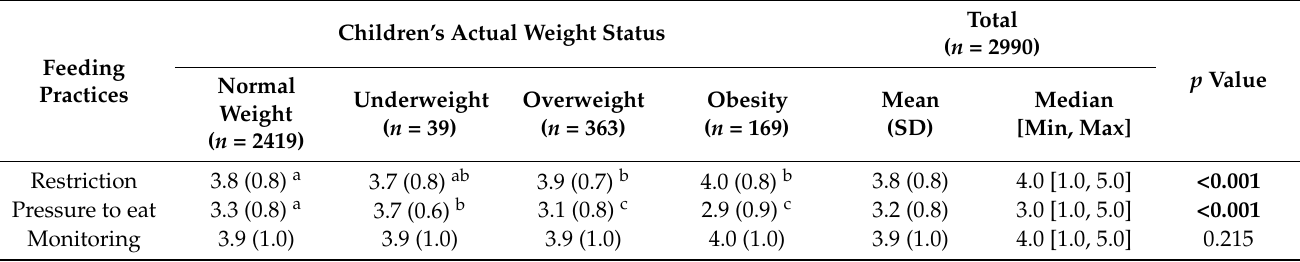
Table 2. Scores of feeding practices according to children’s weight status: Mean